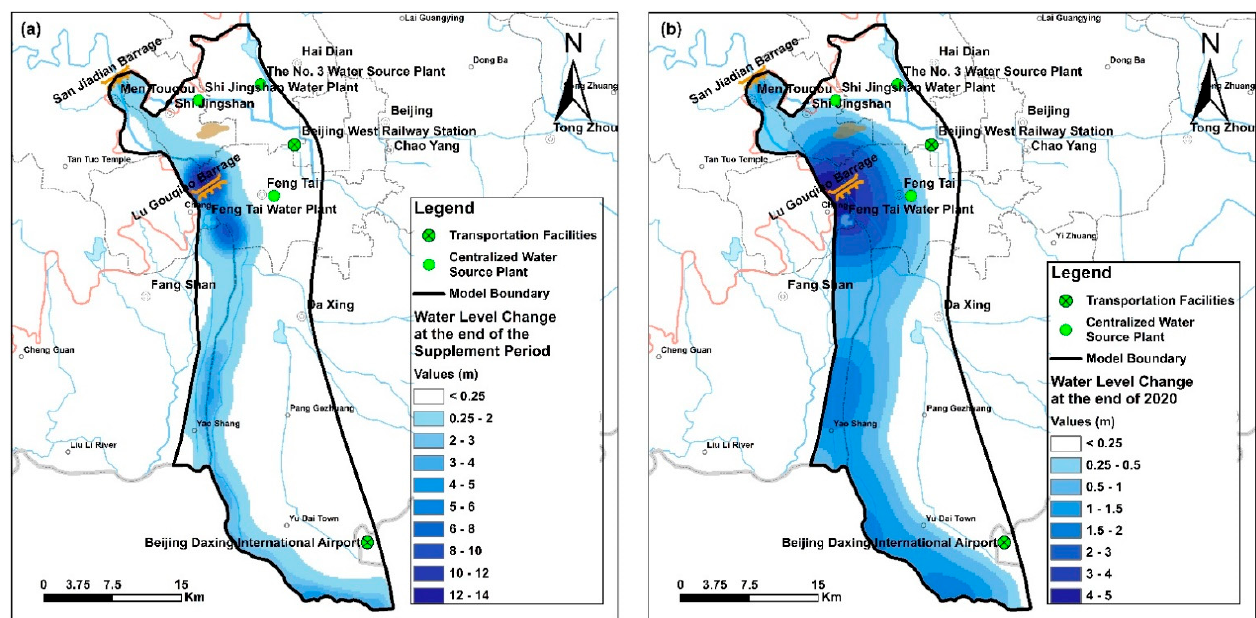
Figure 9. ( a ) Variation map of groundwater level in the study area at the end of the supplement period in 2020. ( b ) Variation map of groundwater level in the study area at the end of 2020.